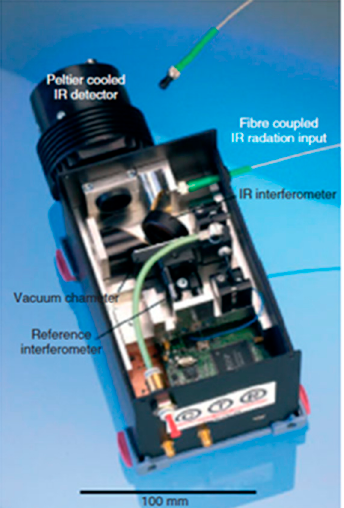
Figure 13. A compact FTS using type A MEMS micromirror. (Reprinted with permission from Reference [37] SPIE).